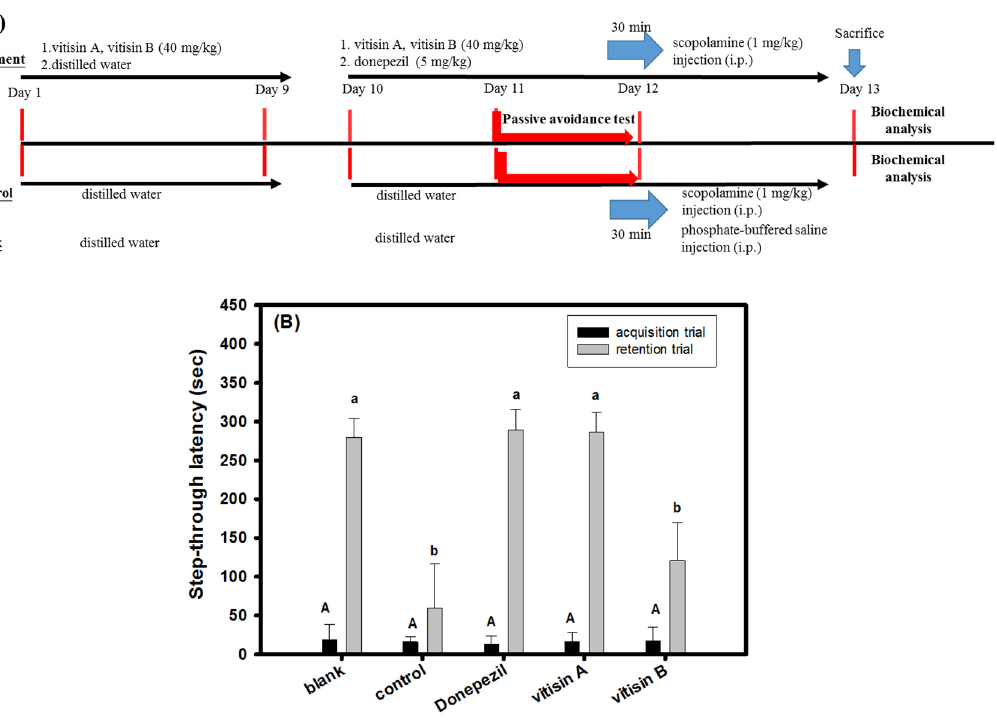
Figure 5. Effects of vitisin A or vitisin B pretreatments (40 mg/kg) on the improvements impaired learning and memory functions in scopolamine-treated amnesiac ICR mice. ( A ) The experimental protocol. There were five groups and each group contained 6 heads of ICR mice, including the blank, the control, the vitisin A (40 mg/kg) group, the vitisin B (40 mg/kg) group, and the donepezil group (the positive control); ( B ) the learning and memory behaviors (the step-through latency, sec) in the passive avoidance test. The scopolamine-injected mice without any sample treatments were used as the control. The one-way analysis of variance (ANOVA) and the post hoc Tukey’s test were used to compare the differences among multiple groups in the step-through latency ( B ). It was considered as the significant difference ( p < 0.05) among groups which the marked different uppercase letters in the acquisition trial or the marked different lowercase letters in the retention trial.